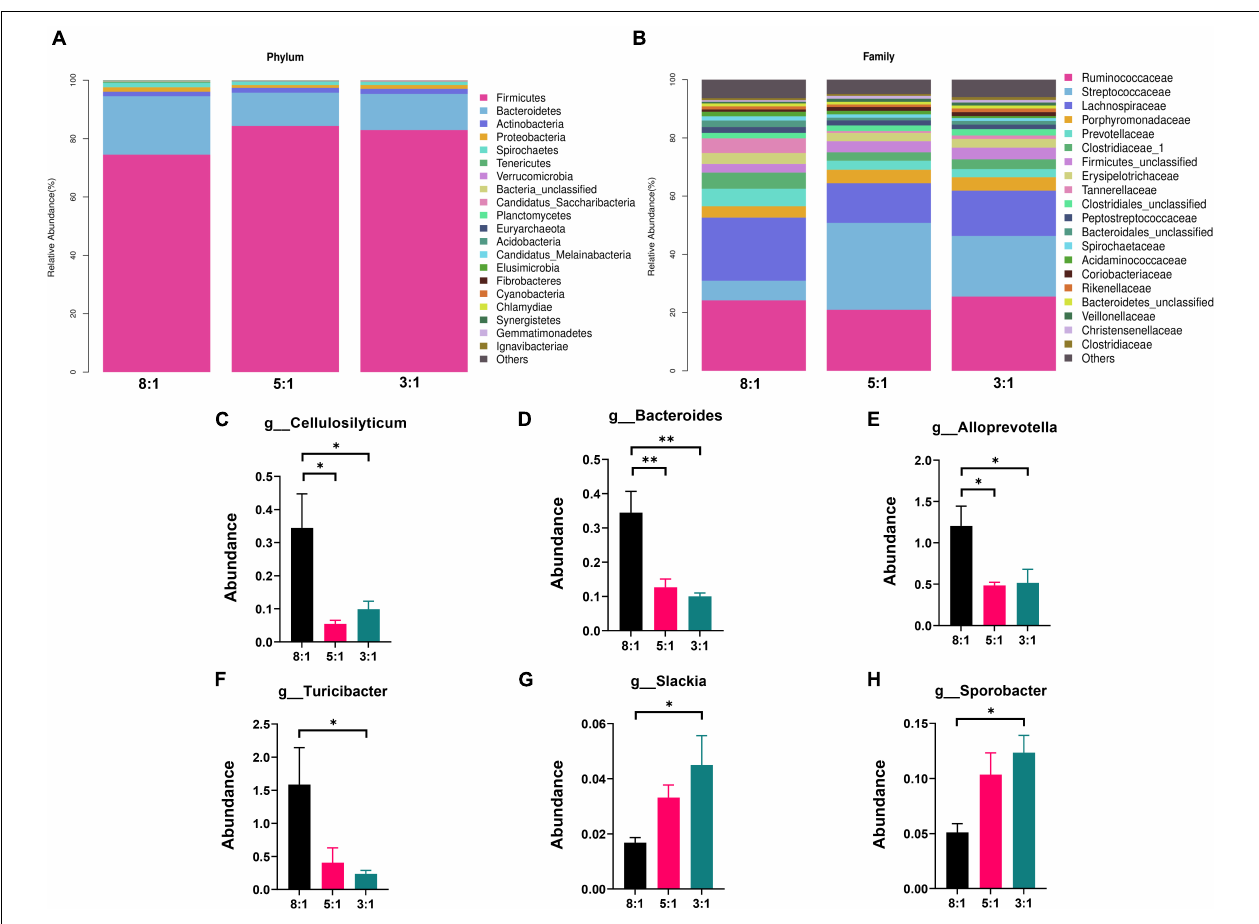
FIGURE 3 | The relative abundance of bacteria in colonic digesta of Heigai pigs at the phylum, family and genus level. (A) Differential bacteria in colonic digesta at the phylum level. (B) Differential bacteria in colonic digesta at the family level. (C–H) The relative abundances of bacteria in colonic digesta at the genus level. 8:1, 5:1, 3:1: different n-6/n-3 PUFA ratio diets. Data are presented as mean ± SEM ( n = 5). ∗ P < 0.05, ∗∗ P <